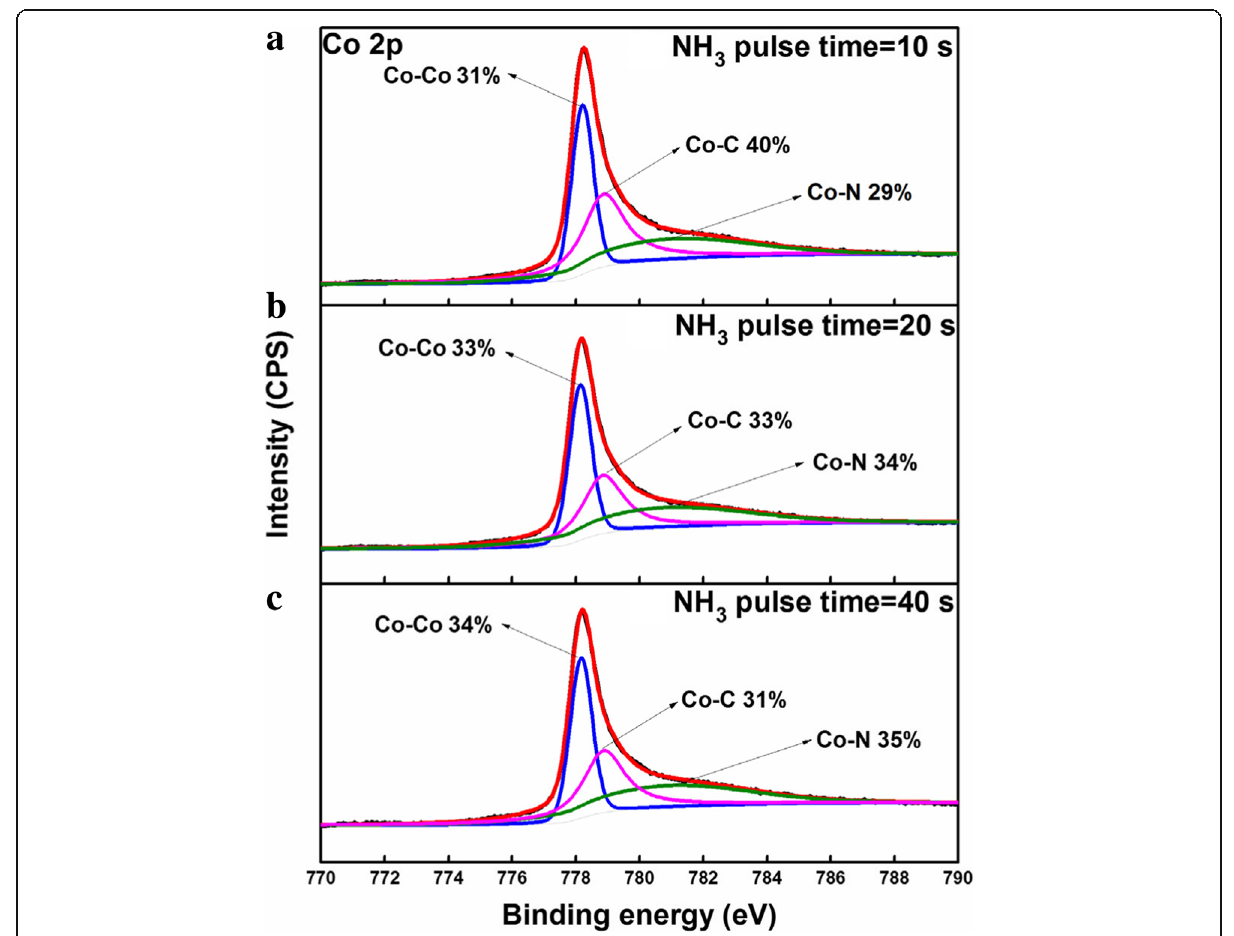
Fig. 7 The XPS spectra of the Co films with different NH 3 plasma times: a 10 s; b 20 s; c 40 s